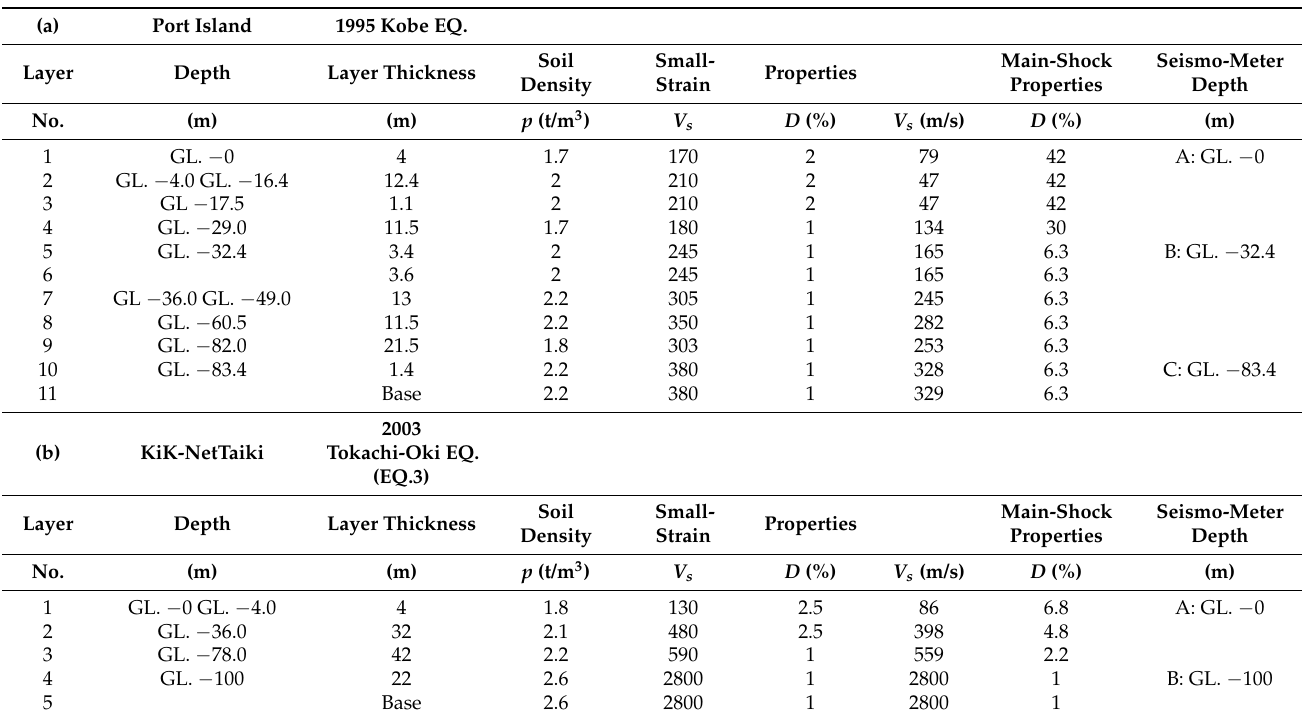
Table 2. Soil profiles and properties at two vertical array sites: ( a ) PI and ( b ) KiK-net